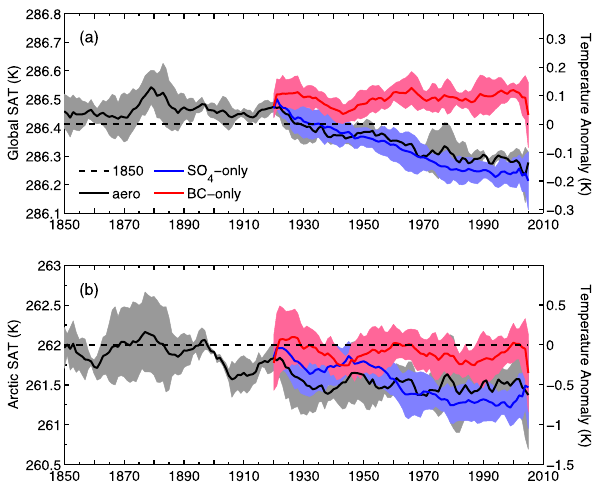
Fig. 2. Time series of area-weighted, annual-mean surface air temperature (SAT) over the globe (a) and Arctic (b) for all aerosol forcing (black), sulfate-only forcing (blue) and BC-only forcing (red). Shading indicates one standard deviation of ensemble members. A 9-year running mean was applied. A pre-industrial (year 1850) control run is shown in black dashed line.